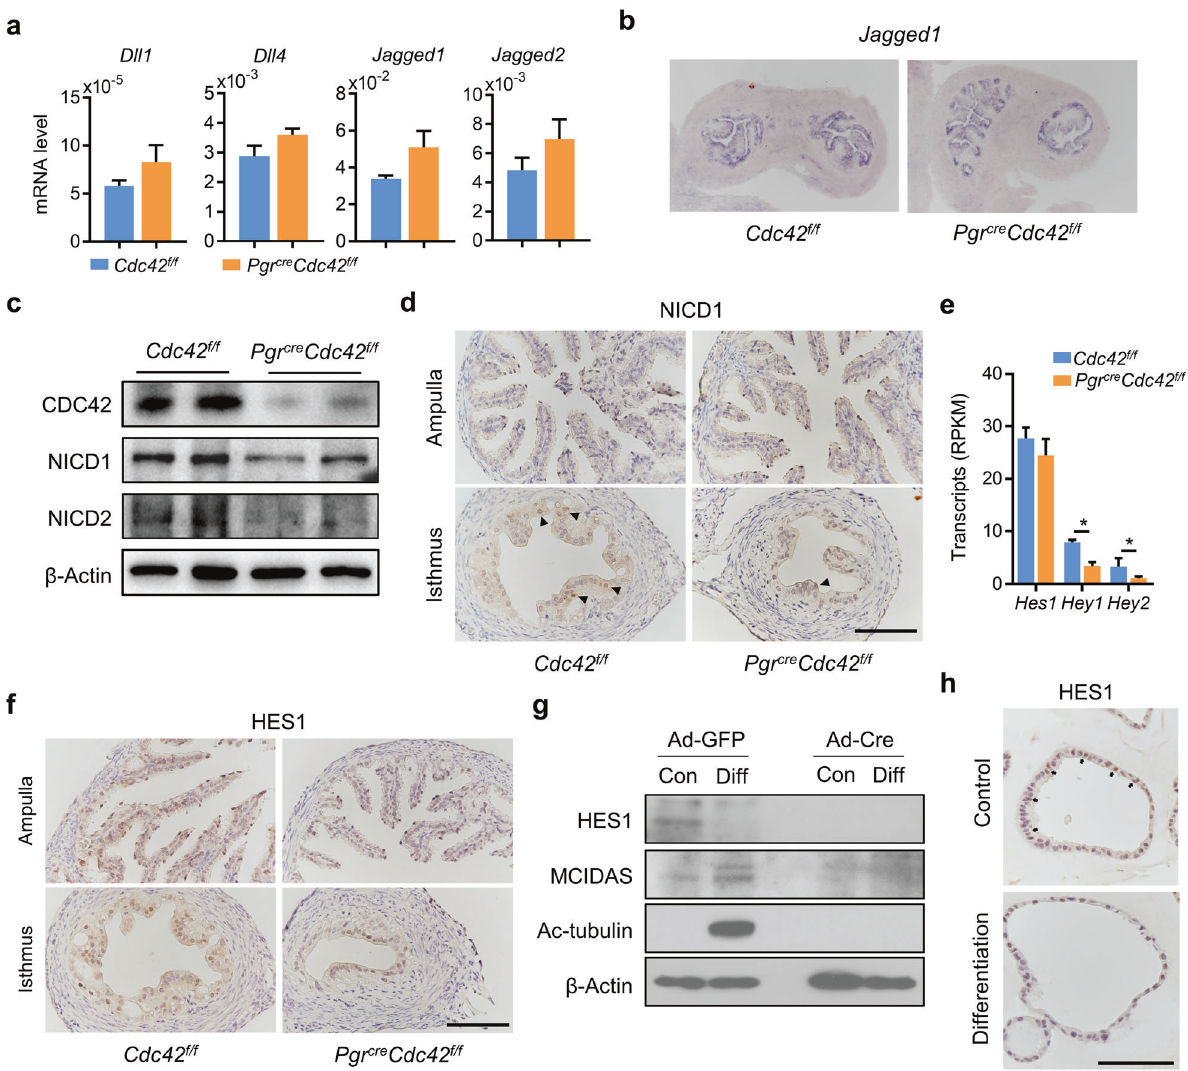
Fig. 4 CDC42 regulates multiciliogenesis independent on Notch signaling. a RT-qPCR analysis of Dll1 , Dll4 , Jagged1 , and Jagged2 mRNA in Cdc42 f/f and Pgr cre Cdc42 f/f mouse oviducts on day 2. b In situ hybridization of Jagged1 mRNA in Cdc42 f/f and Pgr cre Cdc42 f/f mouse oviducts on day 2. c Western blot analysis of CDC42, NICD1, and NICD2 protein in Cdc42 f/f and Pgr cre Cdc42 f/f mouse oviducts on day 2. d Immunostaining of NICD1 in the ampulla and isthmus of Cdc42 f/f and Pgr cre Cdc42 f/f mouse oviducts on day 2. e RNA-seq analysis of Hes1, Hey1, and Hey2 transcripts (RPKM) in Cdc42 f/f and Pgr cre Cdc42 f/f mouse oviducts on day 2. f Immunostaining of HES1 in the ampulla and isthmus of Cdc42 f/f and Pgr cre Cdc42 f/f mouse oviducts on day 2. g Cdc42 f/f organoids were infected with Ad-GFP and Ad-Cre, then subjected to western blot assays. h Immunostaining of HES1 in the organoids before and after E2 and DBZ induced differentiation. Scale bars, 100 μ m. Mean ± SD. * P < 0.05, Student ’ s t test or ANOVA with Tukey ’ s multiple comparisons test. AKT in the fallopian tube tissue from women with ectopic pregnancy and control women ( P = 0.018; Fig. 7g). We next